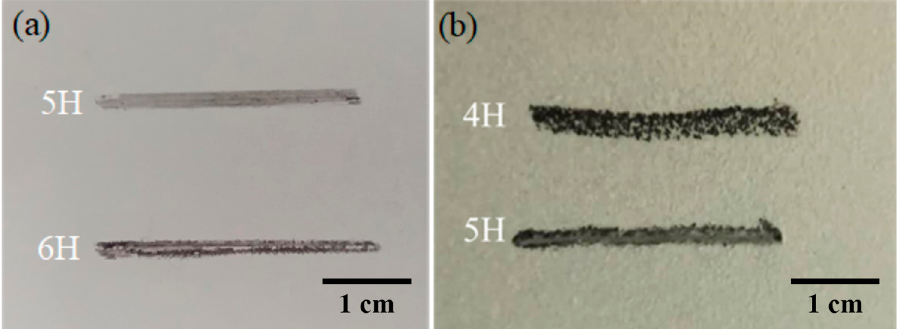
Figure 5. Surface hardness of the superhydrophobic coating. ( a ) Without and ( b ) with modified SiO 2